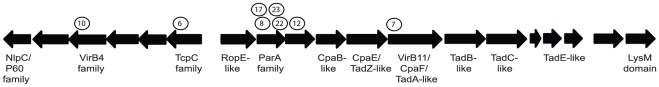
Tight adherence (TAD) gene cluster in P. acnes strain 15.1.R1.The gene cluster [GenBank: JQ612072] encoding proteins similar to TadZABC is shown. This cluster of 20.2 kb is part of the 54 kb mobile genetic element in strain P. acnes 15.1.R1 and other type I P. acnes strains. The annotation is based on sequence similarity, employing the tools BLASTP and InterPro. Genes without annotation are considered hypothetical. CRISPR spacers that are identical or similar to sequences of this mobile genetic element are marked; the numbers refer to Table 1.